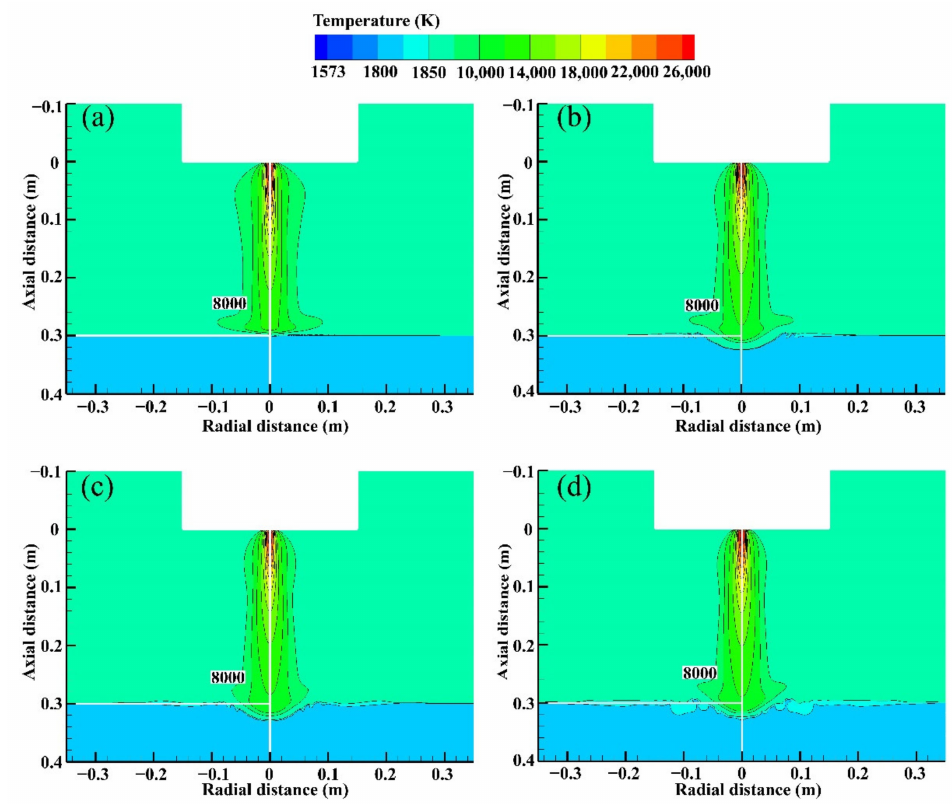
Figure 4. Transient formation processes of cavity with an arc current of 10 kA and an arc length of